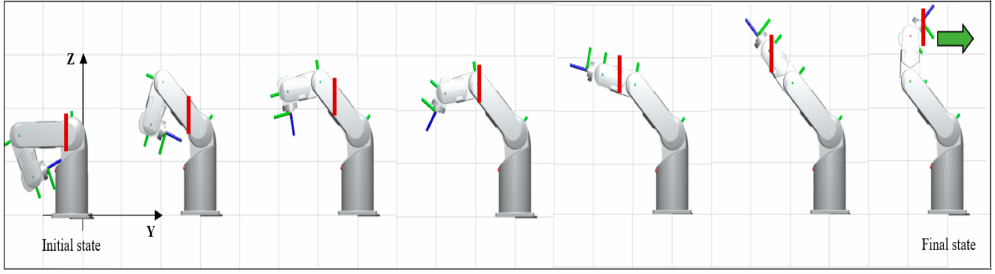
Figure 7. The motion of RV-2AJ